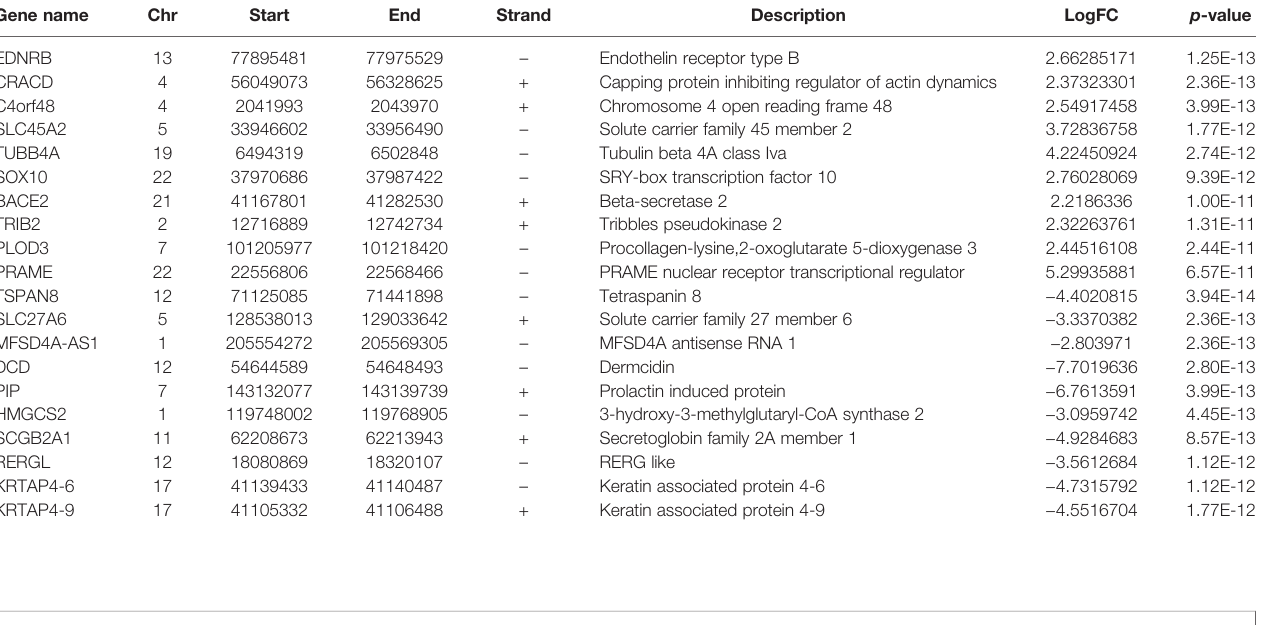
TABLE 3 | DEGs of SKCM (top 10 upregulation and top 10 downregulation according to p -value).